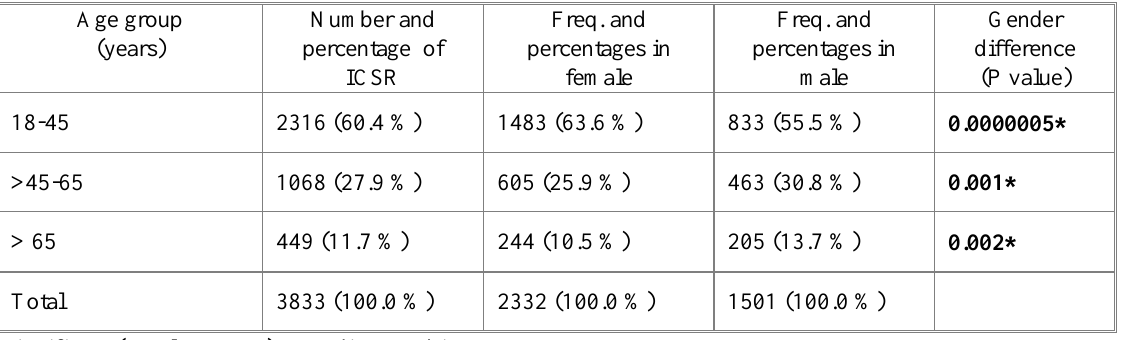
Table 1. Age group distribution of ADRs Age group (years)